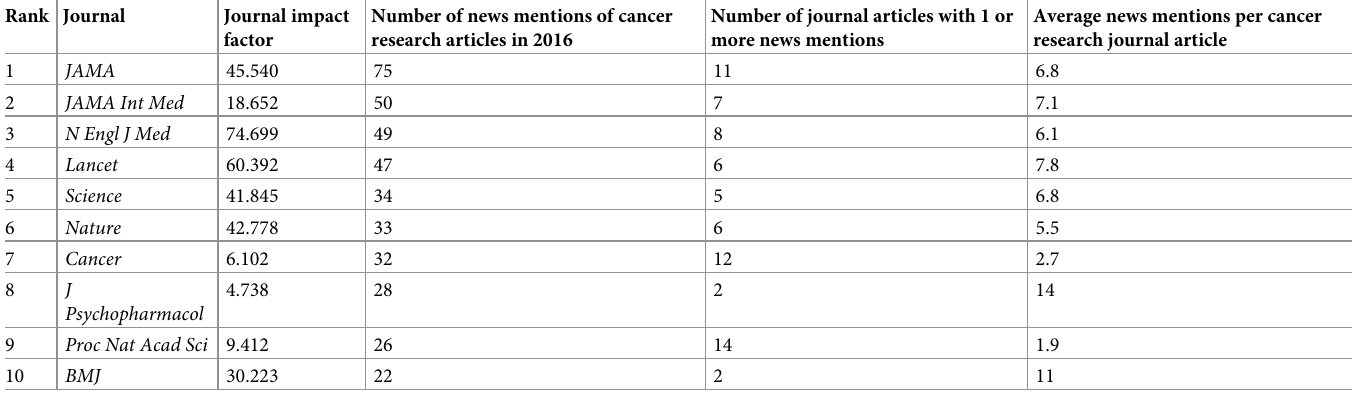
Table 1. Top 10 research journals featuring the most US government-funded cancer research articles with news mentions in